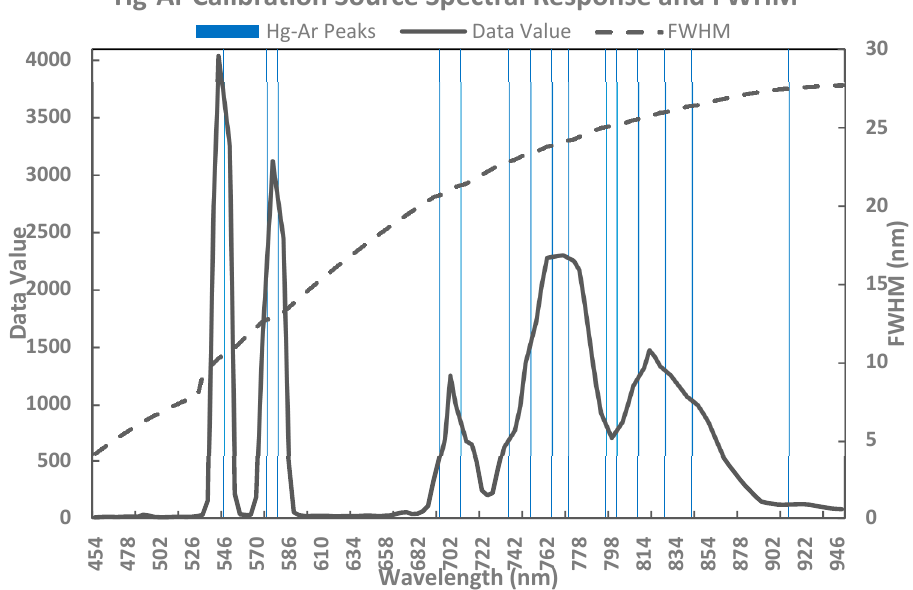
Figure 12. Spectral signature of the mercury-argon (Hg-Ar) calibration source HG-1 (Ocean Optics, Dunedin, FL, USA) recorded by the UHD 185 and FWHM provided by the manufacturer; the vertical lines are part of the Hg-Ar calibration source radiometric peaks.